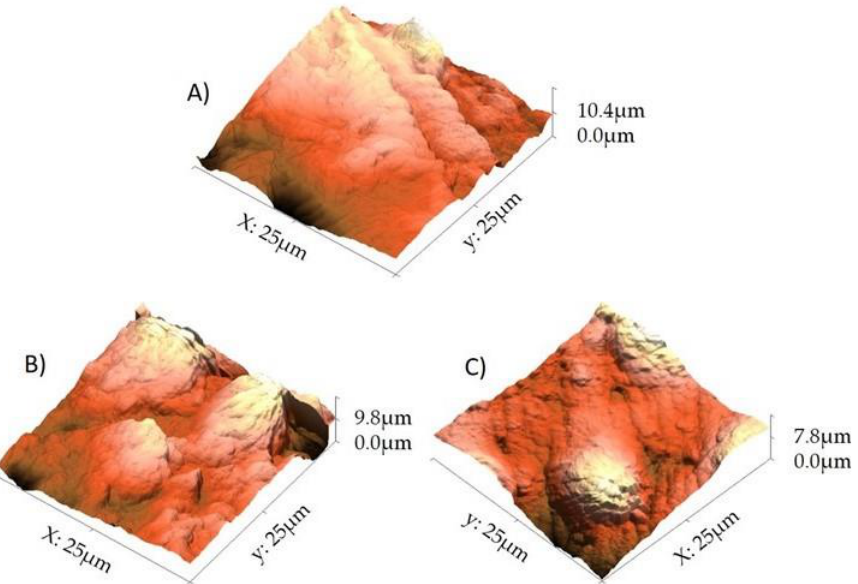
Figure 5. Atomic force microscopy (AFM) images of control ( A ) and concentrations of EAE ( B ) and AE ( C ) M. linifera extracts in worm teguments of S. mansoni .